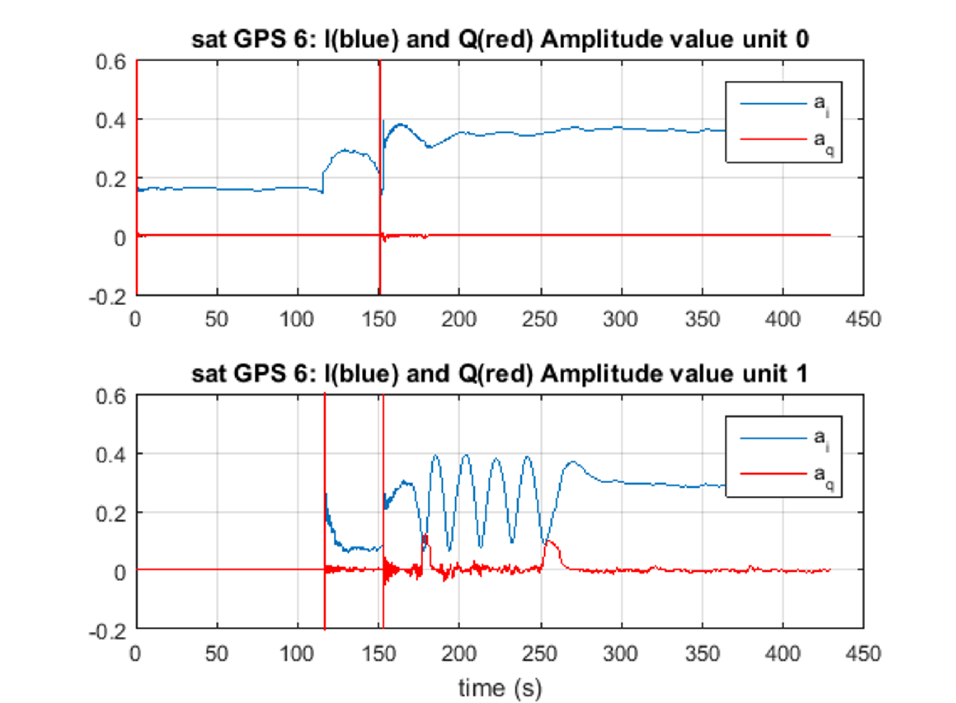
Figure 11. Amplitude estimation for Unit0 ( top ) and Unit1 ( bottom ) for TEXBAT ds3. In blue, the in-phase amplitude estimation, and in red, the quadrature estimation are